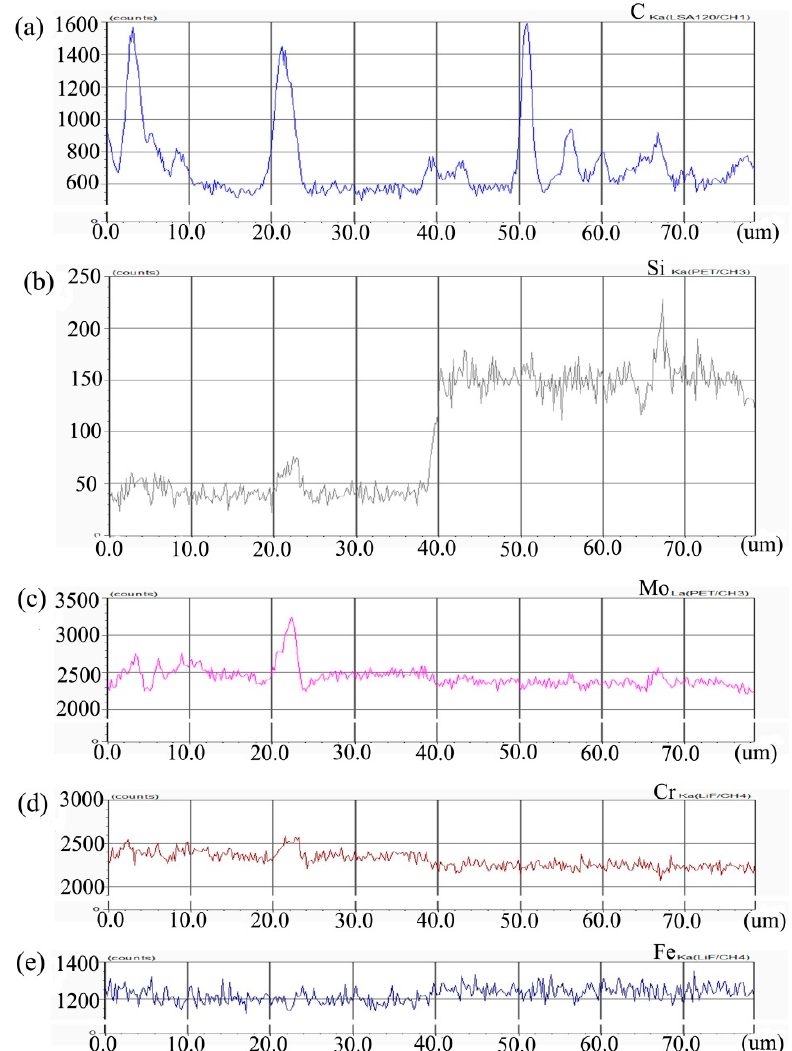
Figure 2. Composition distribution curve of the diffusion couple sample of 0.09Si and 0.45Si alloy after 650 °C/200 h heat treatment: ( a ) C, ( b ) Si, ( c ) Mo, ( d ) Cr, and ( e ) Fe. (The horizontal coordinate